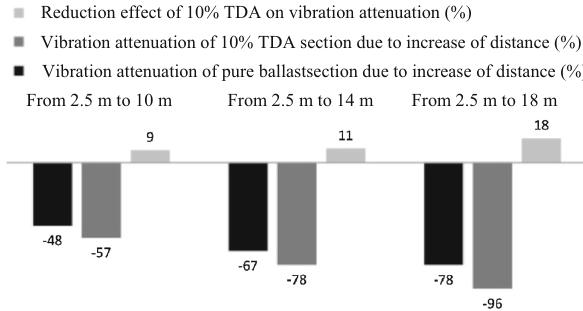
From 2.5 m to 10 m From 2.5 m to 14 m From 2.5 m to 18